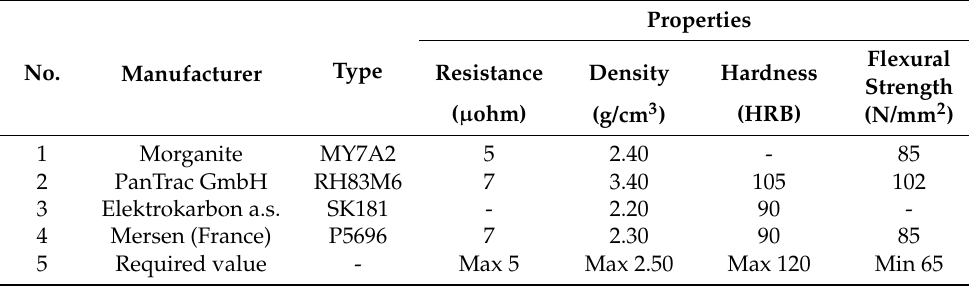
Table 1. Technical data of carbon sliding strips for different sample manufacturers